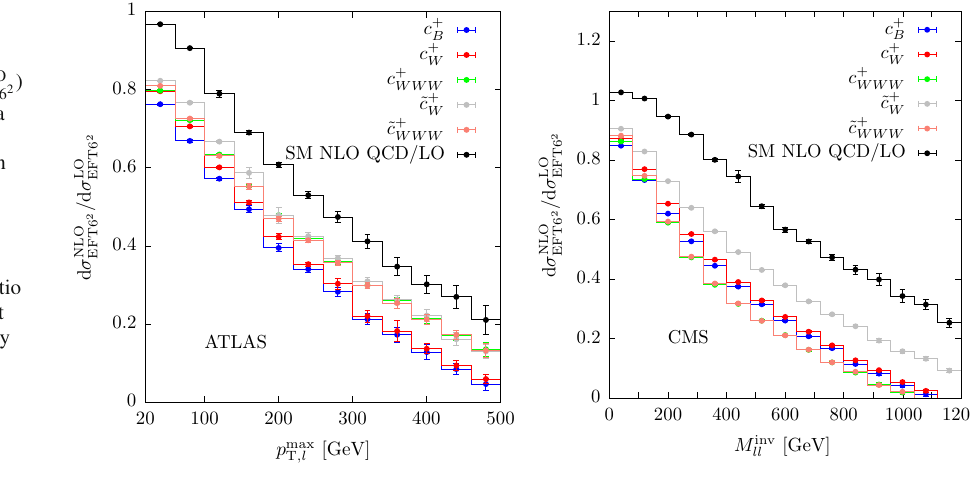
√ s = 13TeV correspond to the statistical error on the last digit. The uncertainties are estimated from the scale dependence, as explained in the text